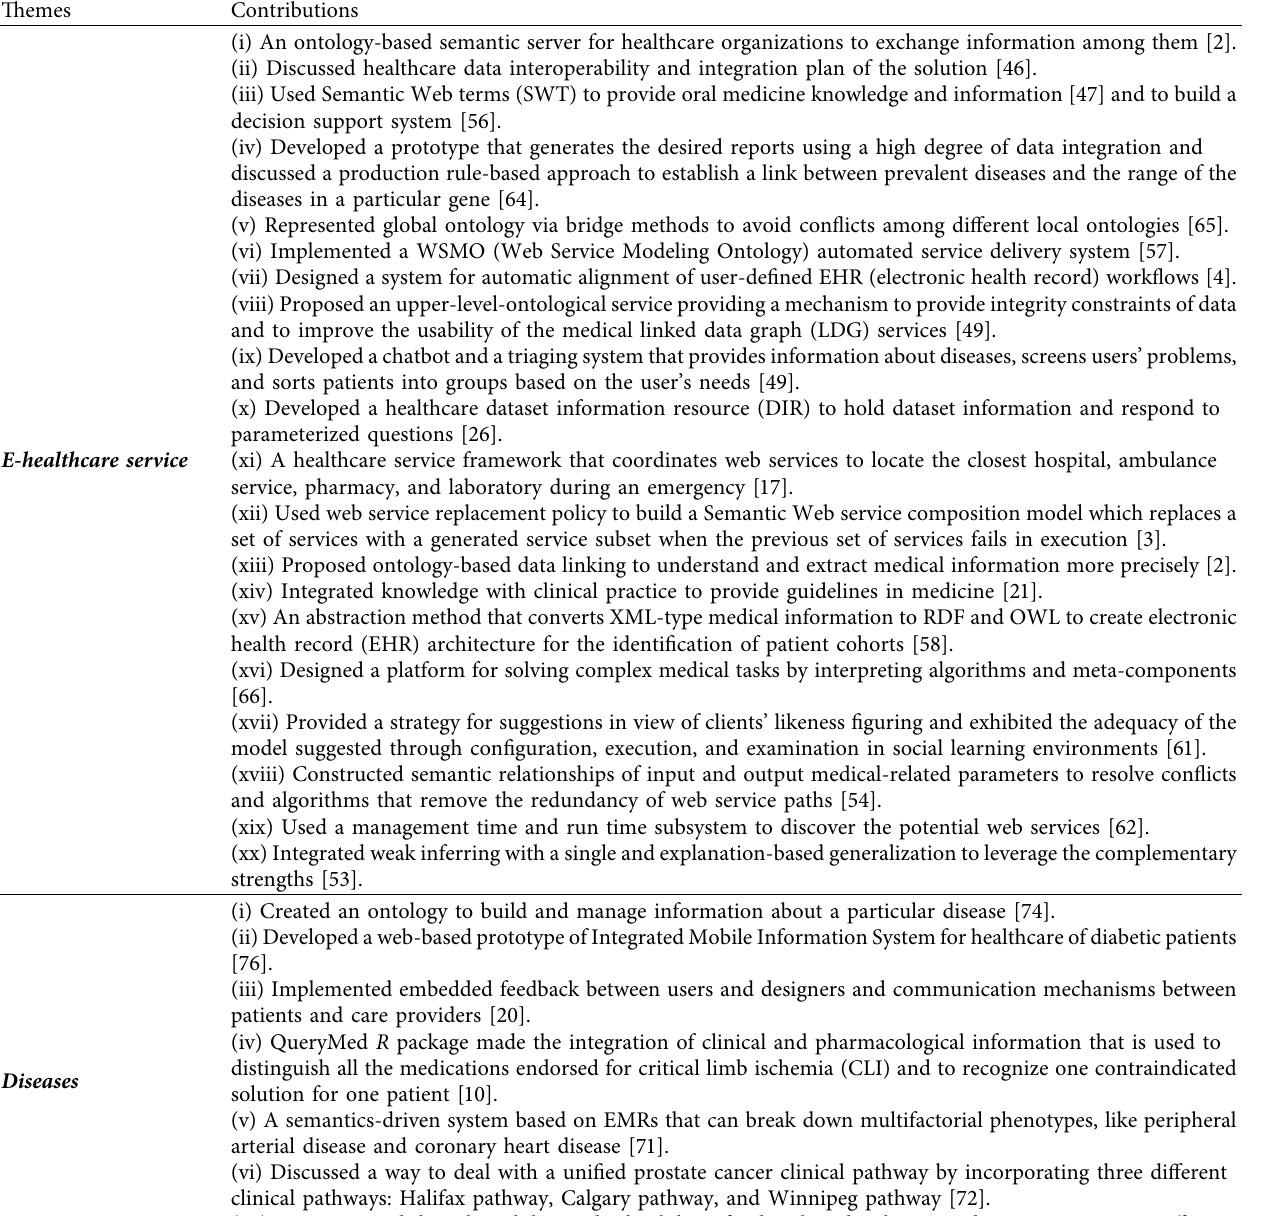
Table 3: Summarization of the research contribution of the selected